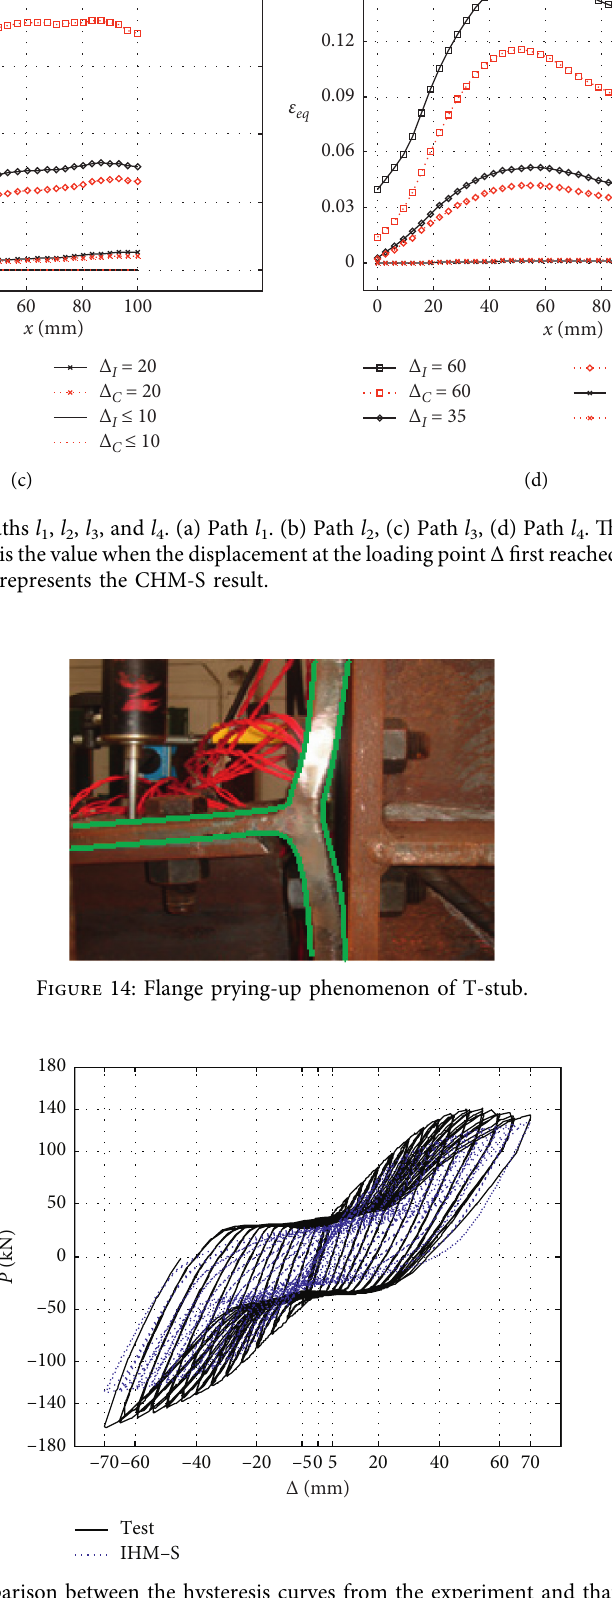
Figure 15: Comparison between the hysteresis curves from the experiment and that of